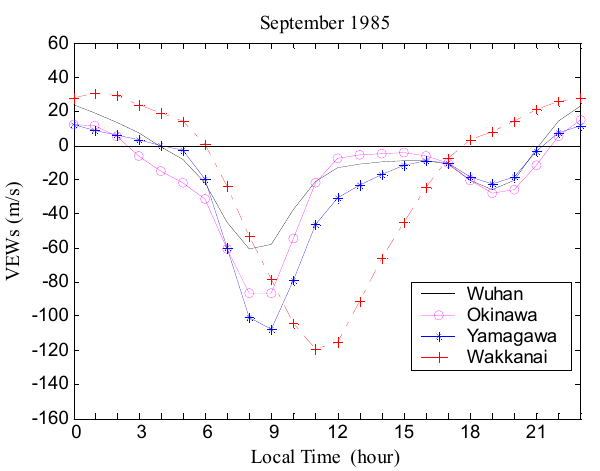
Fig. 3 Comparison of deduced equivalent winds between Wuhan and three other Fig. 3. Comparison of deduced equivalent winds between Wuhan ionosonde stations (Okinawa (127.8º E, 26.3º N), Yamagawa (130.6º E, 31.2º N) and and three other ionosonde stations (Okinawa (127 . 8 ◦ E, 26 . 3 ◦ N), Wakkanai (141.7º E, 45.4º N) in Japan during September, 1985. Yamagawa (130 . 6 ◦ E, 31 . 2 ◦ N) and Wakkanai (141 . 7 ◦ E, 45 . 4 ◦ N), in Japan during September, 1985.